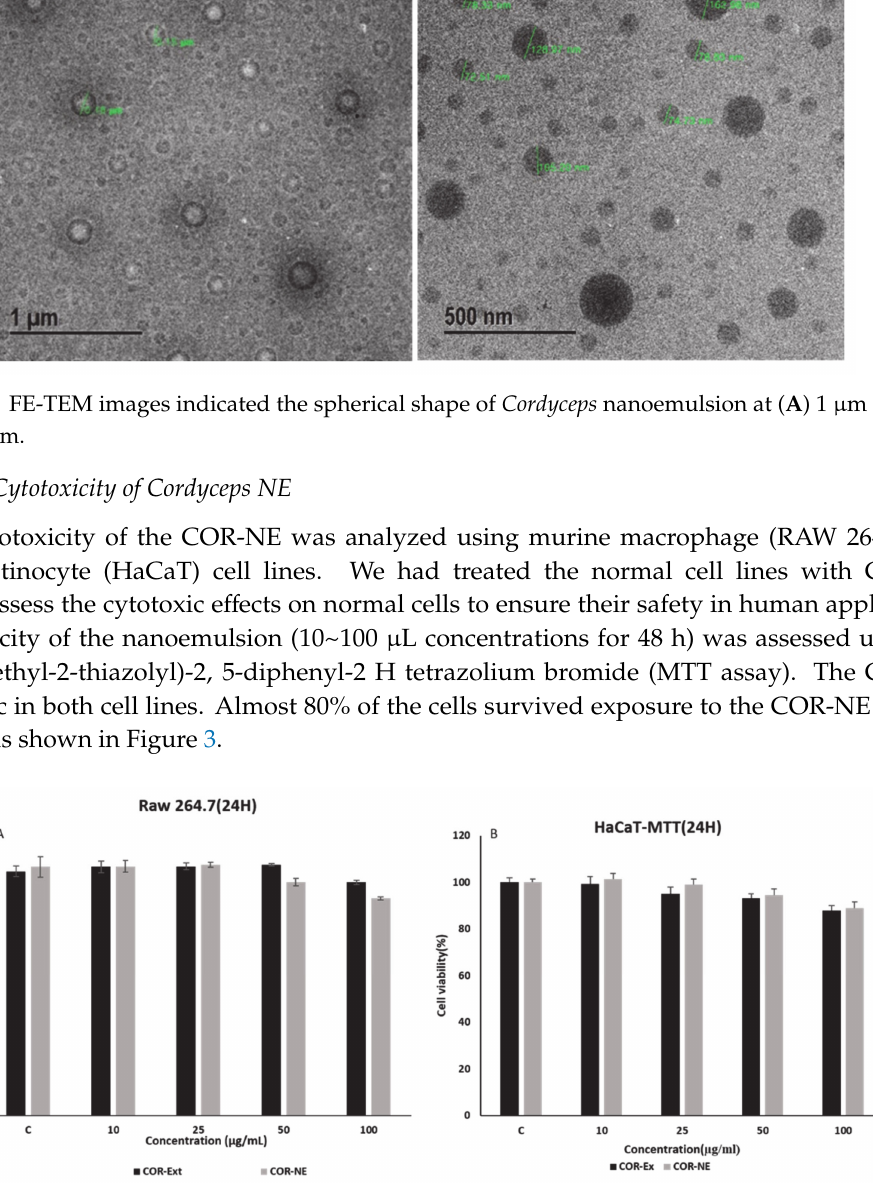
Figure 3. Cell cytotoxicity analysis of Cordyceps nanoemulsion using MTT assay on ( A ) macrophage RAW 264.7 cell line and ( B ) human keratinocyte (HaCaT) cell